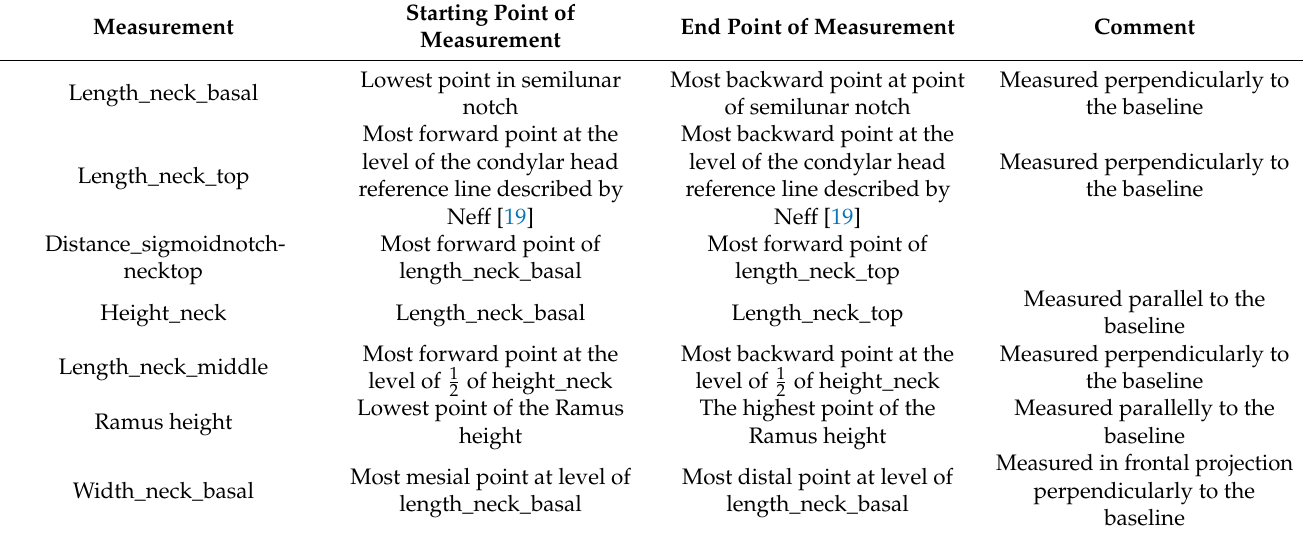
Table 1. Methods for application of anatomical